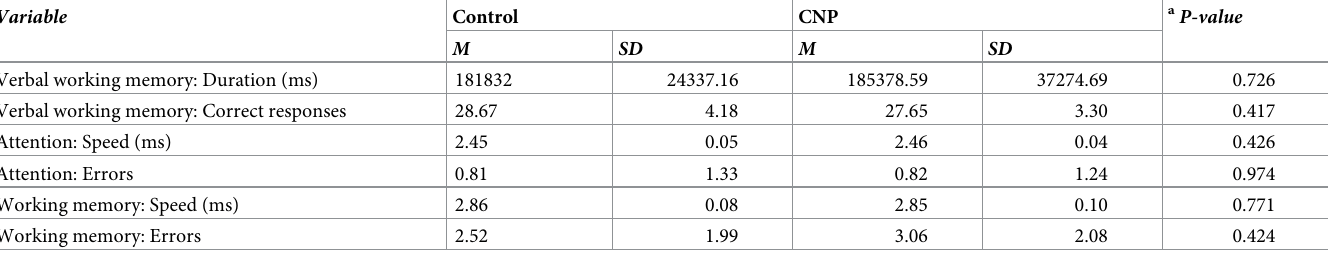
Table 3. Descriptive statistics for cognitive